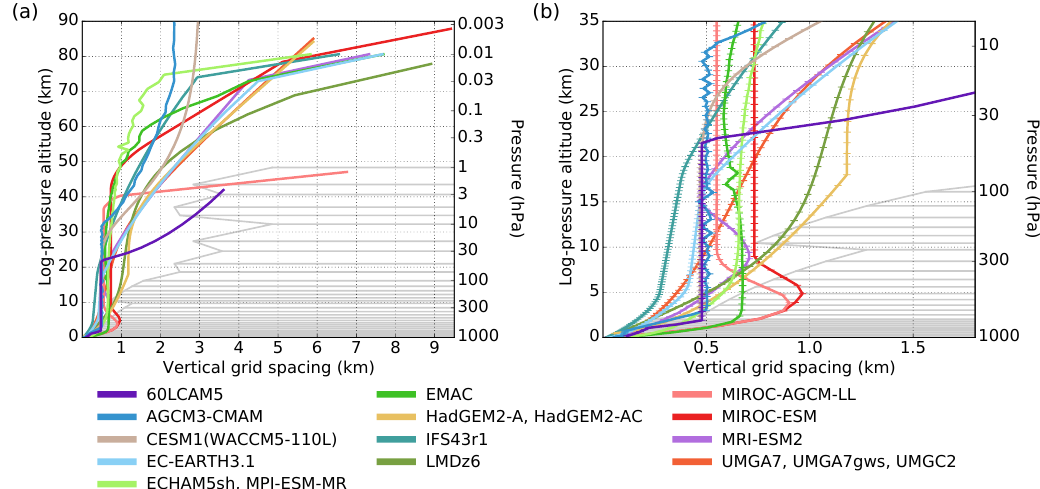
Figure 4. (a) Vertical profiles of vertical grid spacing, (cid:49)z (km), for models participating in QBOi. Log-pressure altitude on the model levels is calculated by assuming a surface pressure of 1013.25hPa and a fixed scale height of 7km. The grey horizontal lines denote the set of 30 QBOi diagnostic pressure levels (see Sect. 4.1), while the grey vertical profile (left end of the grey horizontal lines) indicates the (cid:49)z of the diagnostics. (b) Same as in (a) , but zoomed in to the altitude range most relevant for the QBO. Thin horizontal lines in (b) indicate the locations of the model levels.